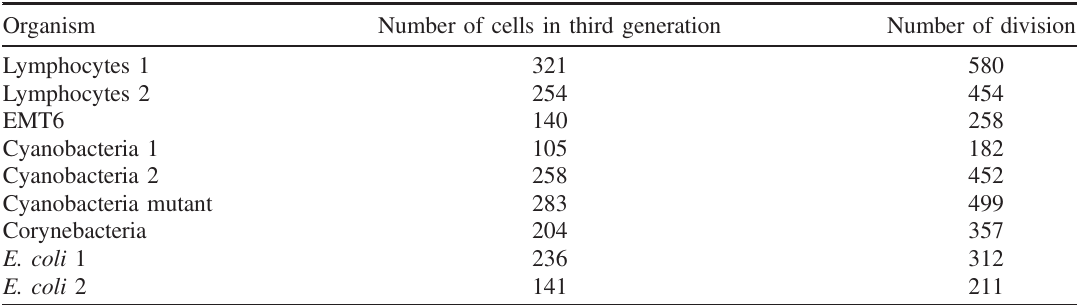
TABLE III. Statistics of the cell divisions observed for the data shown in Table I. Organism Number of cells in third generation Number of